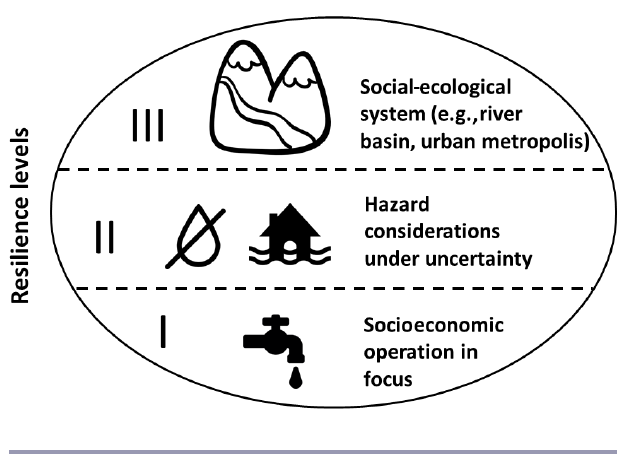
Fig. 1 . Three levels of perceived resilience in the urban water system identified from the empirical data: (1) Socioeconomic operation in focus. (2) External hazard considerations are taken. (3) A larger social-ecological system, e.g., river basin or urban metropolis area. (Icons made by Freepik and Darius Dan from